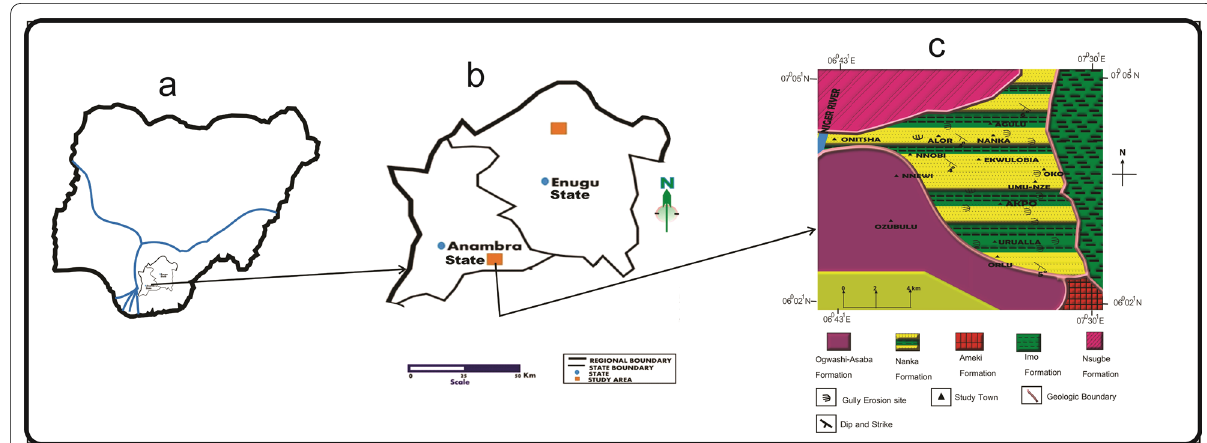
Fig. 2 a Map of Nigeria b Map of the Anambra and Enagu states showing the studies areas (Anejionu et al. 2013; Egbinki et al. 2019). c Geological Map or the study area which falls with 06°55’N; 07°17’E-07°17’E (Nwajide 1977: Egboka and Okpoko 1984)